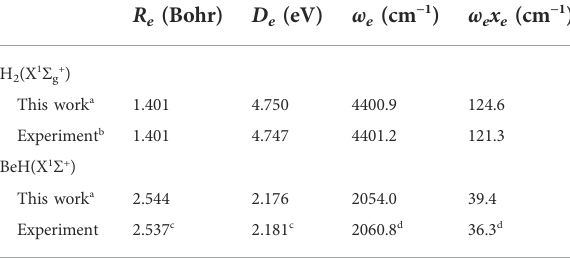
a Obtained on the analytical PECs. b Ref. 39. c Ref. 40. d Ref. 41.